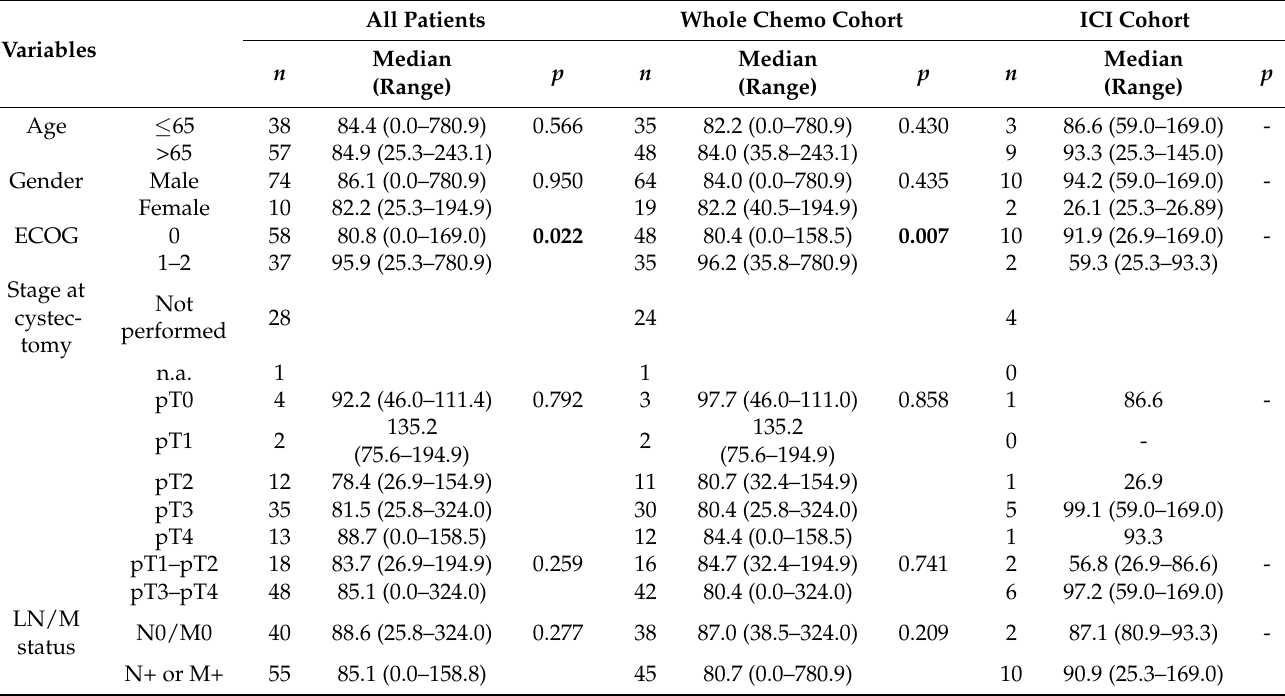
Table 2. Correlation of pretreatment sPD-L1 levels (pg/mL) with clinicopathological parameters.